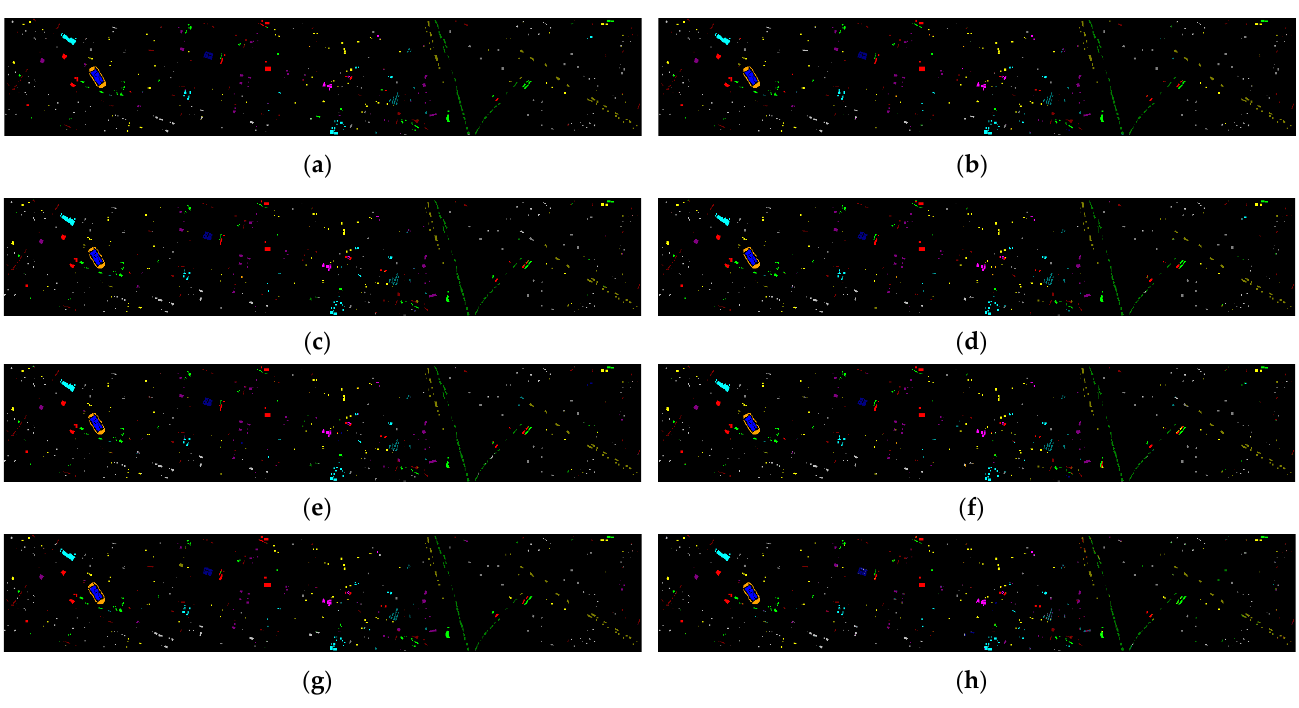
Figure 28. Classification maps using different methods on the Houston dataset: ( a ) SCL – MSR; ( b )